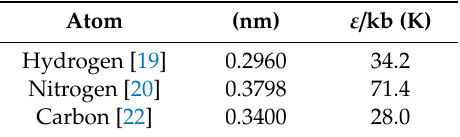
Table 1. Lennard-Jones interaction parameter.